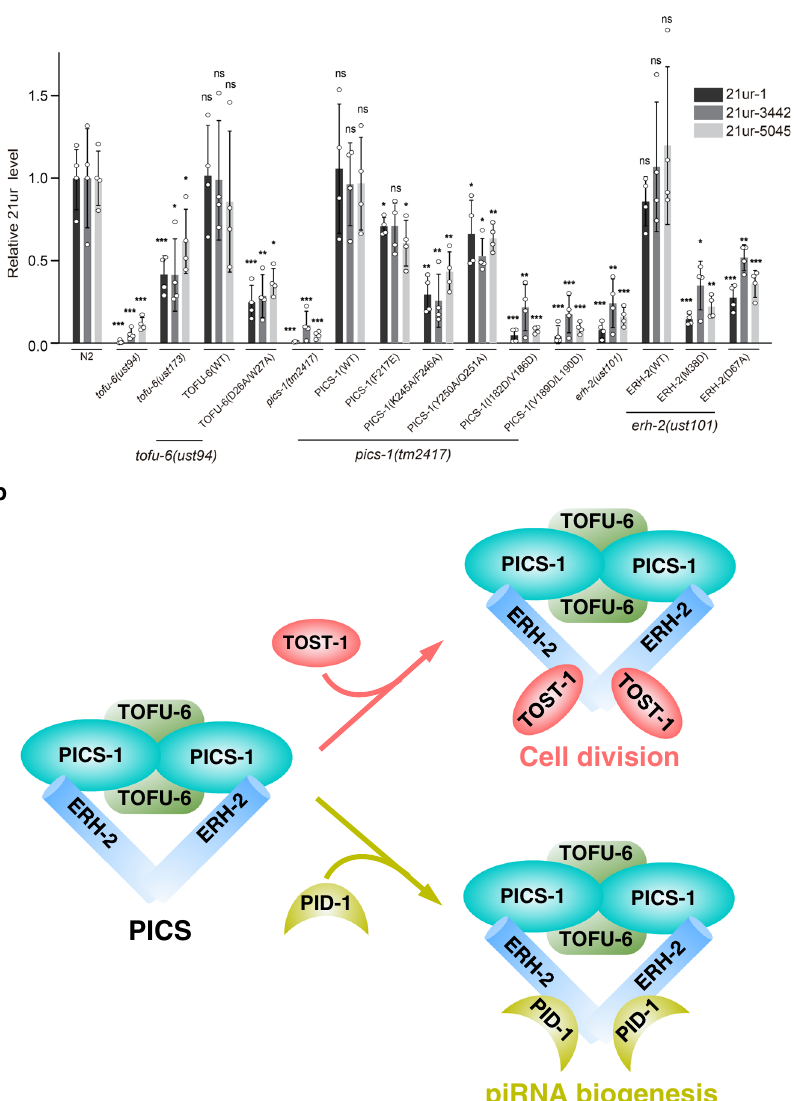
Fig. 7 piRNA biogenesis depends on the interactions between PICS subunits. a 21U-RNA levels are detected by quantitative RT-PCR with RNA levels normalized to total reverse transcribed RNAs. Mean± SD; *** p < 0.001, ** p < 0.01, * p < 0.05; ns, not signi fi cant; n = 4 replicates; two-tailed paired t-tests. b A working model for PICS complex. PICS complex consists of four core subunits, and functions in chromosome segregation and piRNA biogenesis via two mutually exclusive factors, TOST-1 and PID-1,